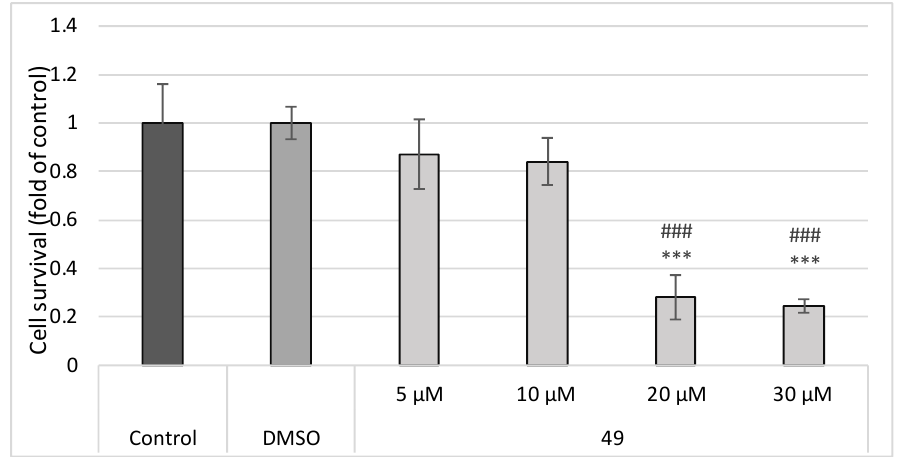
Figure 1. Effect of compound 49 on BrdU incorporation in A549 cells. Lung cancer cells were exposed to compound 49 at concentrations ranging from 5 to 30 μM for 72 h. The data show the mean ± SD values of three independent experiments. Statistical significance: ### p < 0.001 vs. Control, *** p < 0.001 vs. DMSO.